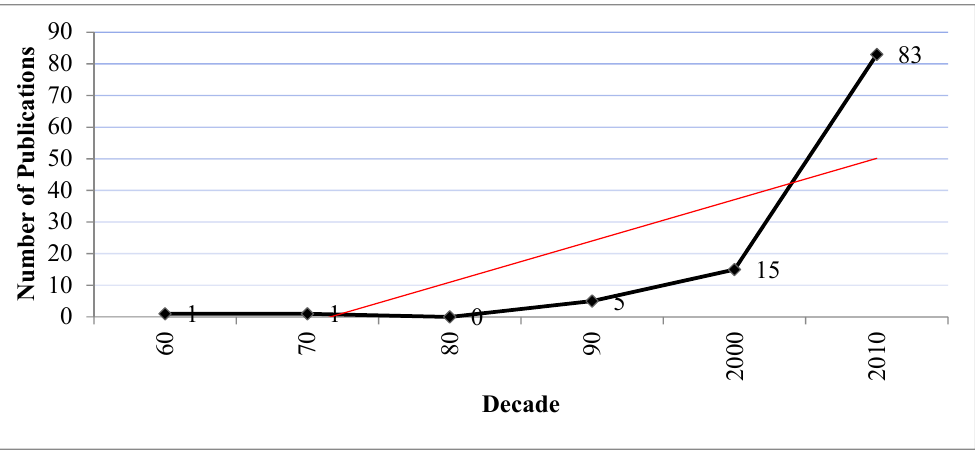
Figure 2. Distribution of the number of publications per decade. * The linear adjustment of the number of publications is represented by the red line.